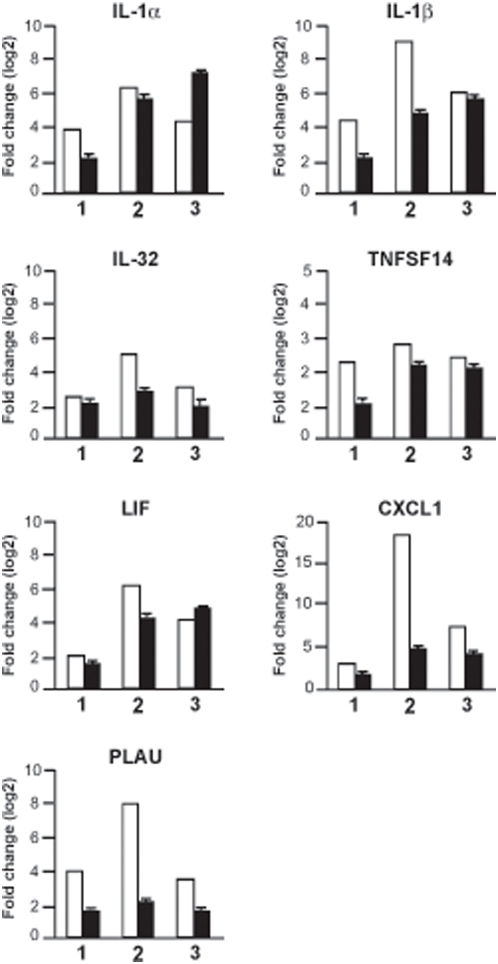
Validation of seven target sequences using qRT-PCR.The expression levels of seven genes commonly regulated by CF-TG cells and wt TG cells stimulated with P. aeruginosa-secreted products were determined by microarray (white bar) and qRT-PCR (black bar). The results of microarrays are expressed as the log2 ratio of the fold change, and the results of qRT-PCR represent means±SEM of three experiments performed in triplicate. (1) unstimulated CF-TG cells vs. unstimulated wt TG cells; (2) stimulated vs. unstimulated wt TG cells; (3) stimulated vs. unstimulated CF-TG cells.